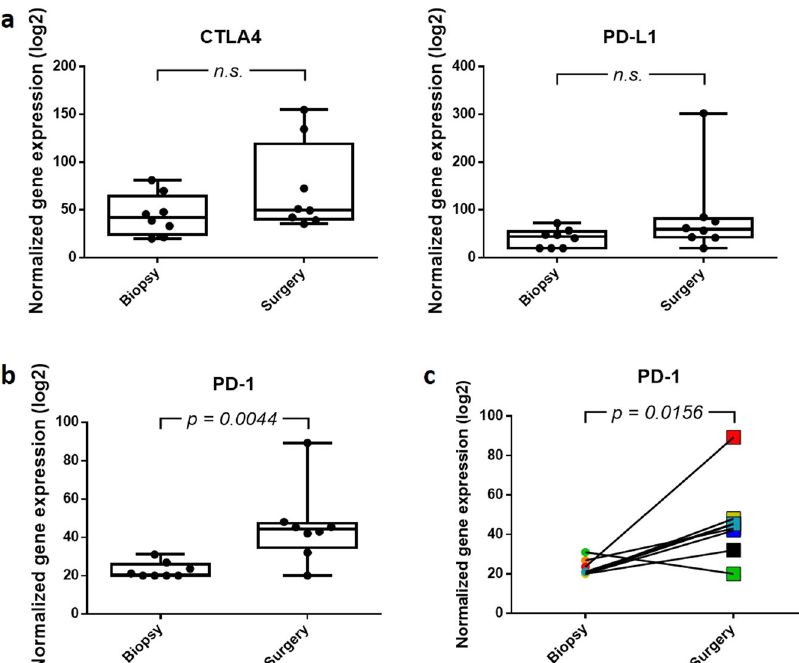
Fig. 5 Normalized gene expression of CTLA4 , CD274 (PD-L1), and PDCD1 (PD-1) before and after NACT. a No signi fi cant differences were observed in the CTLA4 and PD-L1 expression between biopsy and surgery EOC samples. The value for each EOC sample is shown. n.s. p > 0.05. b , c NACT causes a signi fi cant increase in PD-1 expression. The plot of PD-1 expression in which the value for each EOC sample is shown ( b ). p Value was determined using Mann – Whitney test. Line graph representing the increase in PD-1 expression in paired biopsy – surgery samples ( c ). Each line represents an EOC patient. p Values were determined using the Wilcoxon test.